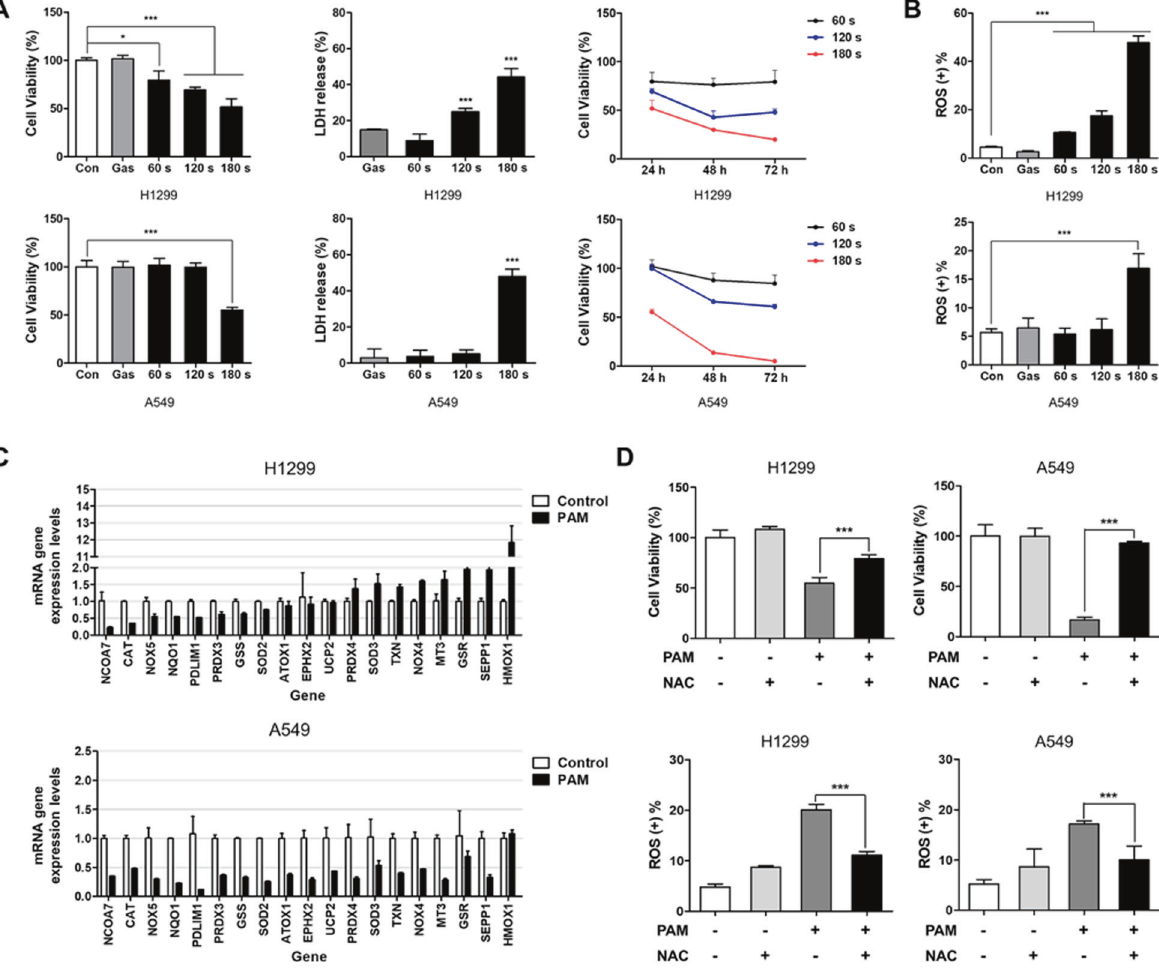
Fig. 1 Plasma-activated medium induces cancer cell death by regulating intracellular ROS. The plasma exposure conditions were 1.9 standard liter per minute (SLM), 7 W input power and three exposure times (60, 120, and 180 sec). A The cell viability and cytotoxicity were measured using MTT and LDH assay. B Intracellular ROS was detected at 24 h after PAM treatment. C PAM regulated mRNA expression levels of oxidative stress genes in H1299 and A549 cancer cells (exposure time: 180 sec). D N-acetylcysteine (NAC, 2 mM) recovered cell viability and suppressed intracellular ROS by PAM treatment. Cells were treated with PAM (180 sec) for 24 h. Data represent the mean ± SD from three independent experiments (* p < 0.05, ** p < 0.01 and *** p < 0.001, as determined by t